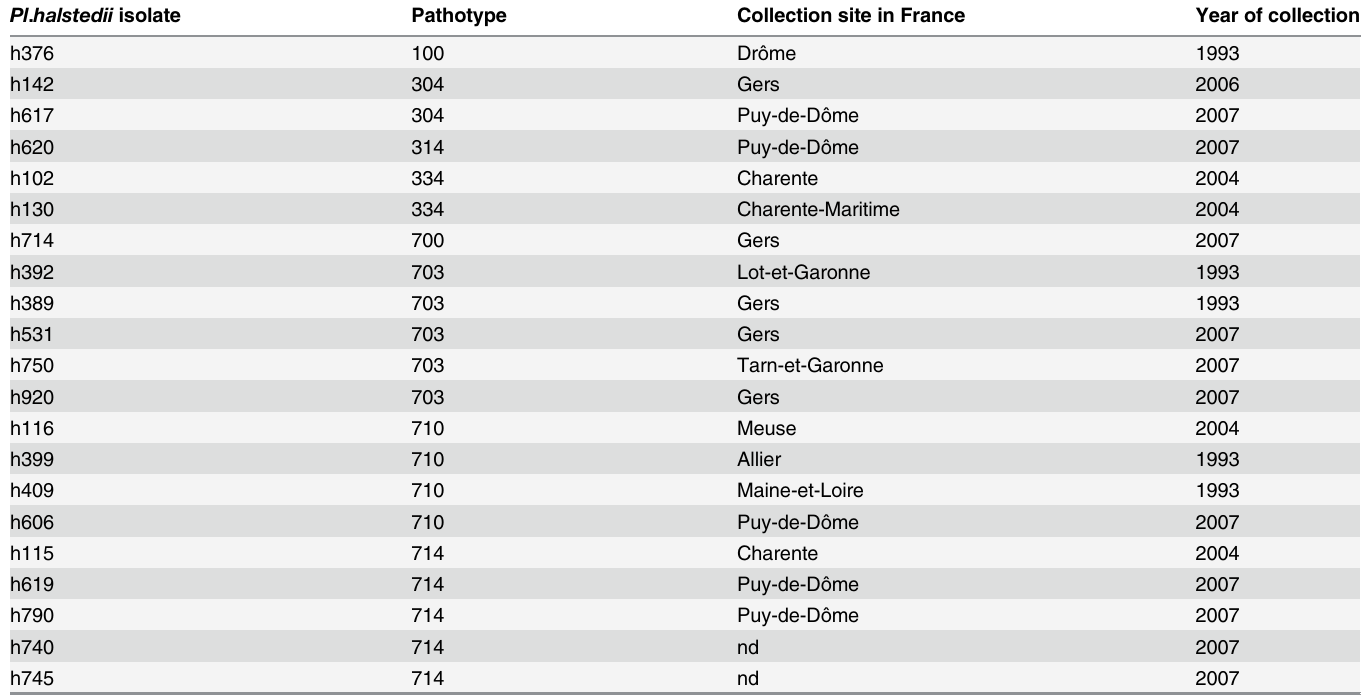
Table 1. Plasmopara halstedii geographical isolates used in this study. Pl . halstedii